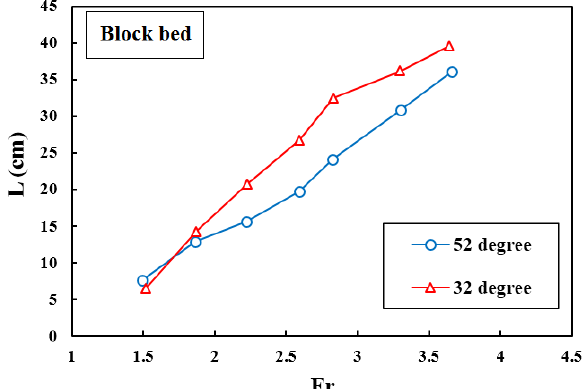
Figure 11. Difference in jet length versus Froude number in flip bucket with different take-off angles. Figure 11. Di ff erence in jet length versus Froude number in flip bucket with di ff erent take-o ff